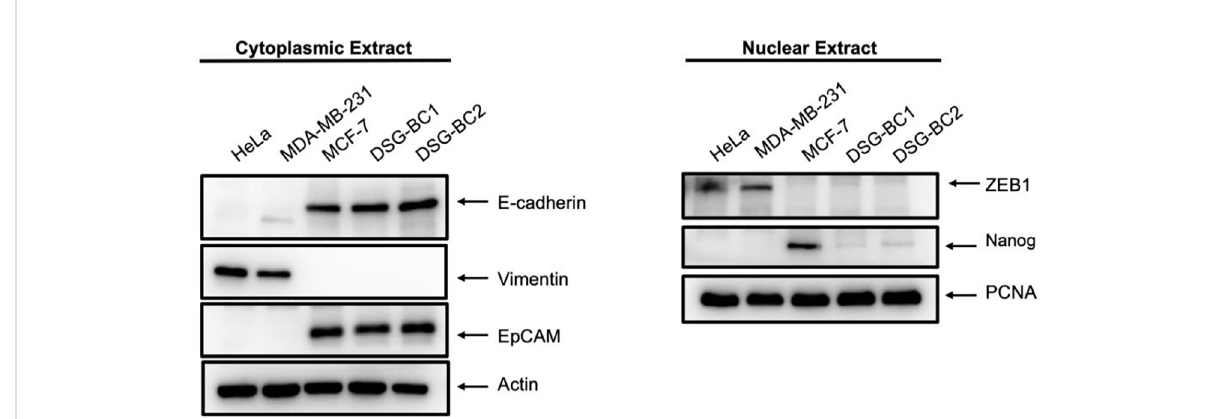
FIGURE 8 Breast cancer cells derived from patients with obesity and normal weight display a strong expression of epithelial markers and a weak and partial expression of mesenchymal markers. Western blot in cytoplasmic (left panel) or nuclear extracts (right panel) were performed as described in materials and methods. 40 ug of total protein were separated using SDS-PAGE and after electro-transfer membranes were probed with the indicated antibodies against EMT markers. Antibodies were diluted as described in material and methods. Actin was used as a loading control for cytoplasmic extract analysis, and PCNA served as loading control for nuclear extracts. Representative image of 3 independent